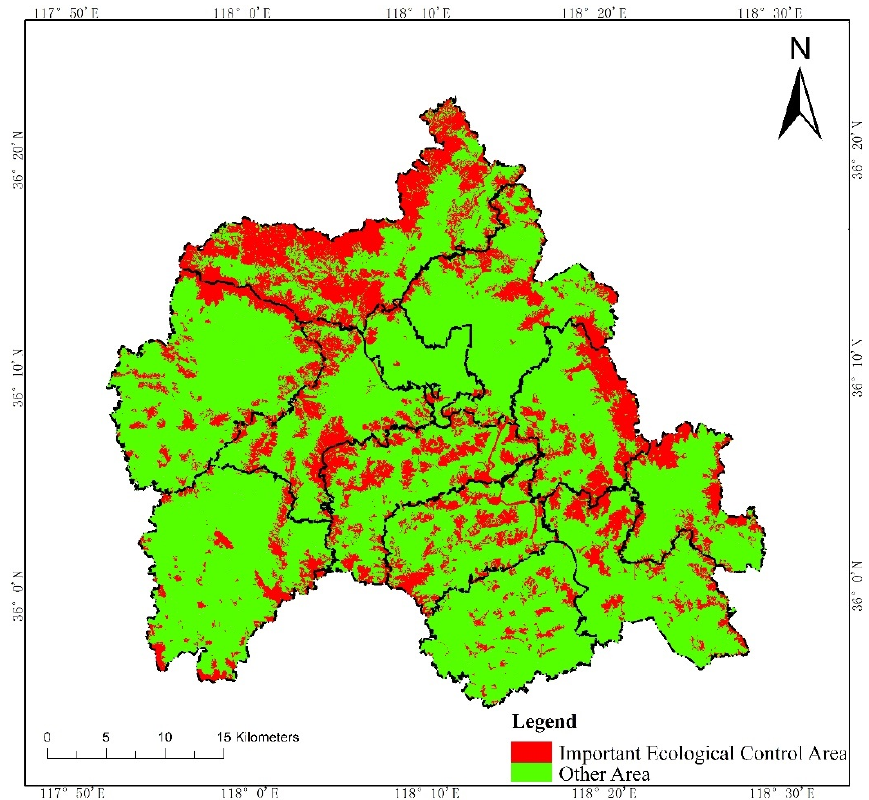
Figure 4. Comprehensive evaluation of ecological protection.